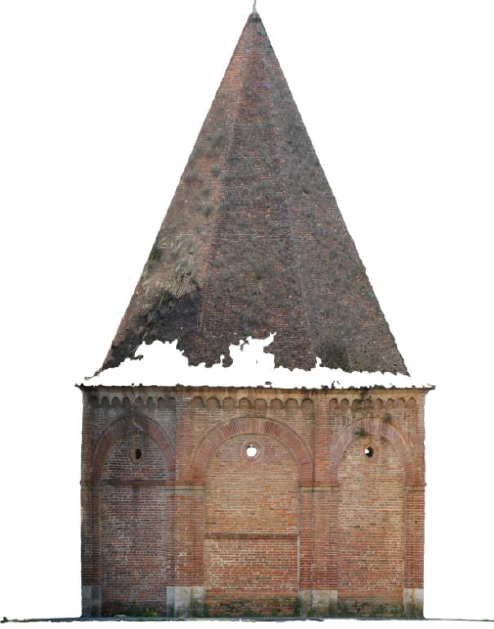
Figure 10. External